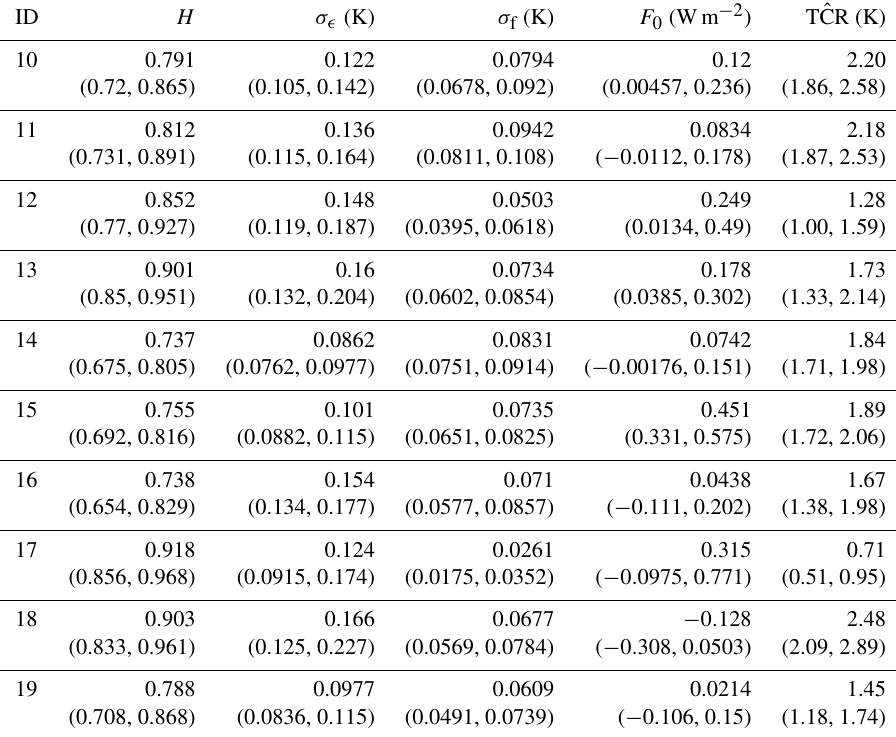
Table 4. This table contains marginal posterior means and 95% credible intervals for the model parameters and the transient climate response obtained from fitting the scale-invariant response model to temperature data from the last 10